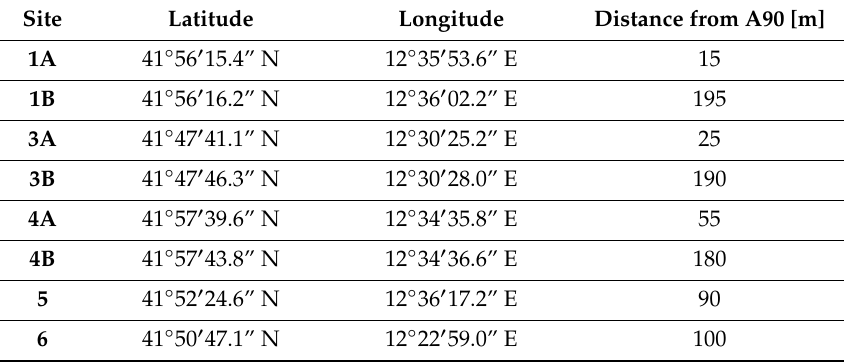
Figure 8. DYNAMAP sensors position (red spots) along the A90 motorway and measuring sites (blue squares) during the summer measuring campaign. Table 2. Measuring sites, geographical coordinates, and distance from the A90 Motorway